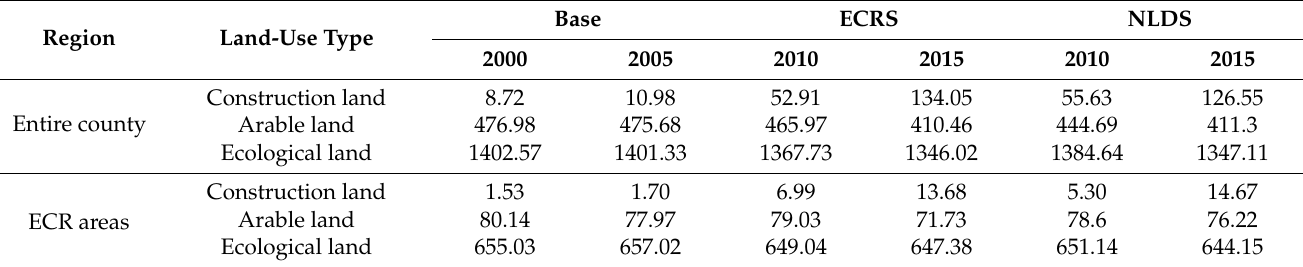
Table 1. Anji County land use results under ECRS and NLDS (km 2